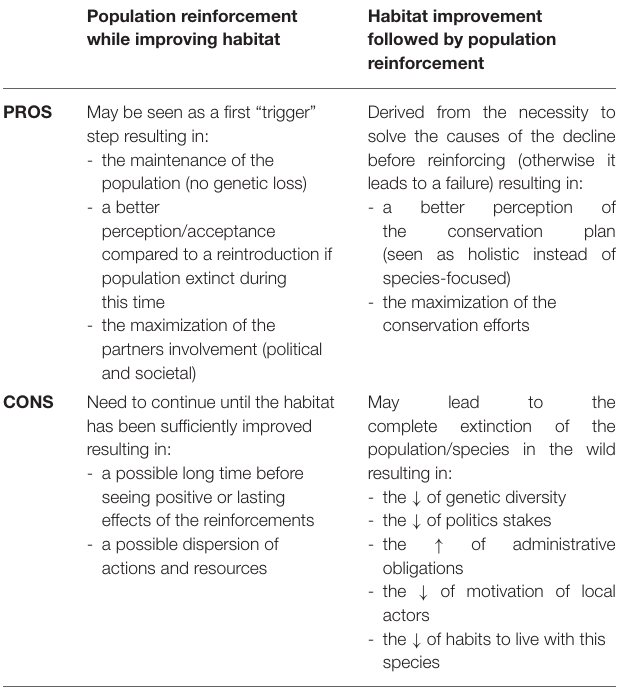
TABLE 1 | Pros and cons of the strategies considering different priorities for population reinforcement and habitat improvement. Population reinforcement while improving habitat